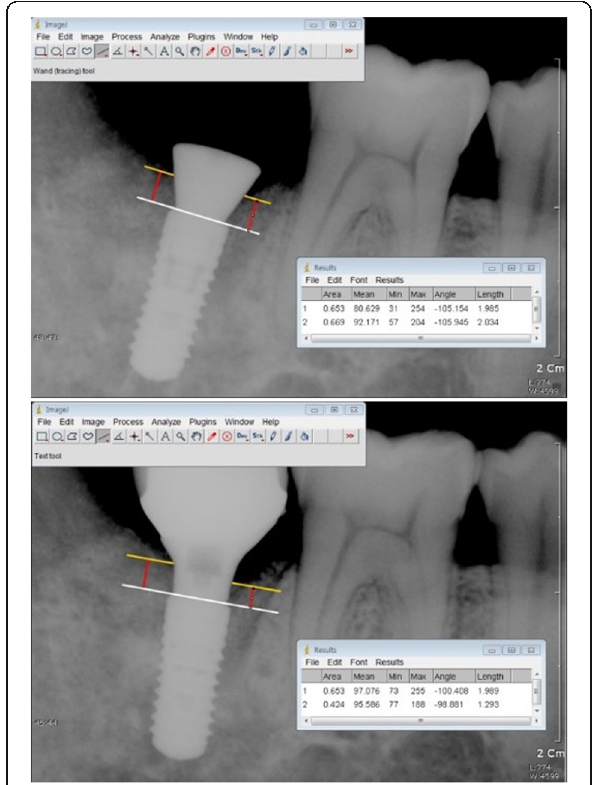
Fig. 1 Peri-implant bone measurements, both after implant